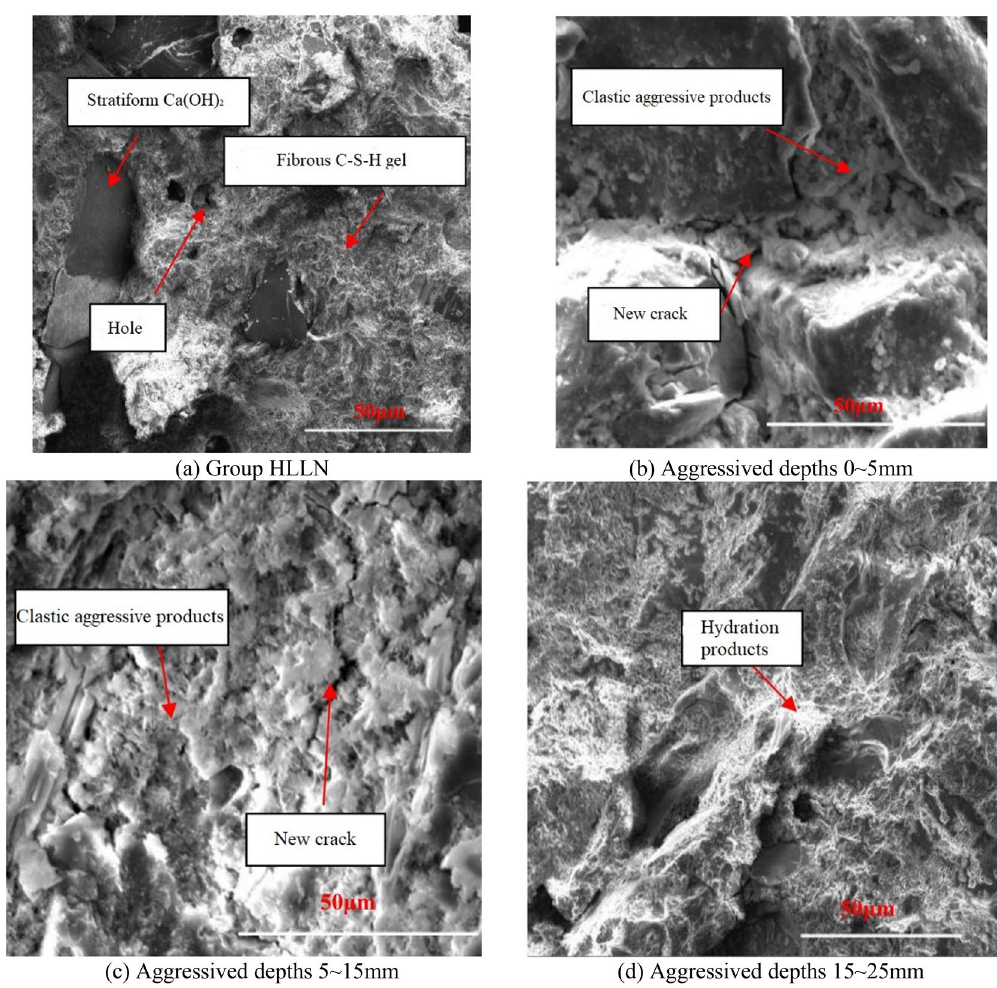
Figure 5. Scanning electron microscope of samples without erosion and after 180 days of